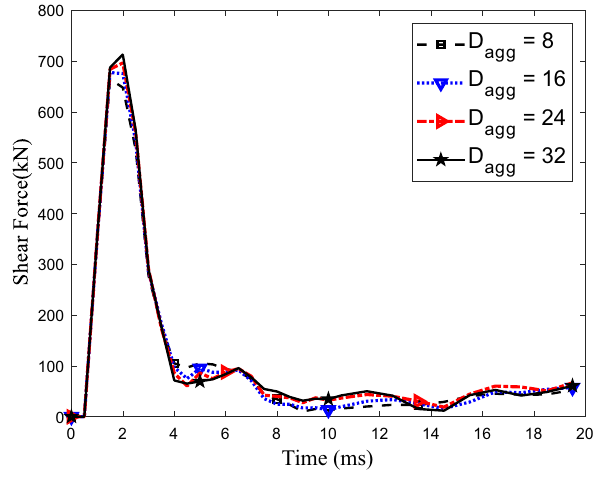
Fig. 18 Critical section shear force–time histories for BM1